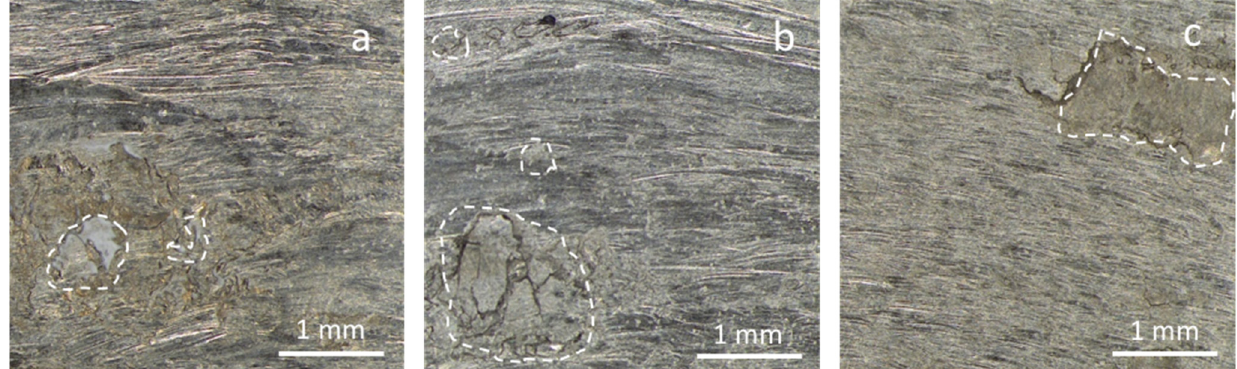
Figure 8. ( a ) Surface of a part obtained by SPIF process at 300 °C with WC tool of a diameter of 12 mm; inner area 2 in the rolling direction. ( b ) Surface of a part obtained at 300 °C with steel of 12 mm diameter; inner area 2 in the rolling direction. ( c ) Surface of a part obtained at 400 °C with WC tool of 12 mm diameter; inner area 5 in a 45° rolling direction. Inner areas according to the reference of Figure 2.